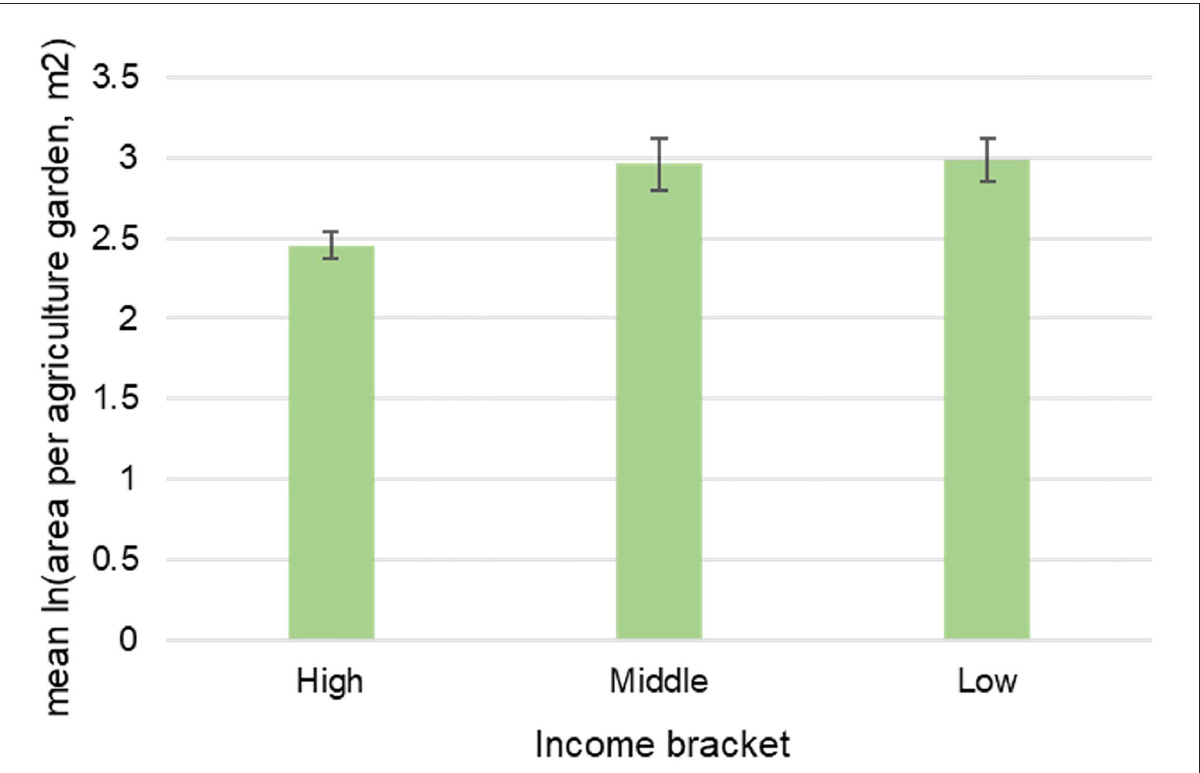
FIGURE3 Natural log-transformed mean area per agriculture garden by income bracket (low, middle, high) in the Twin Cities. Error bars represent the 95% confidence interval of the displayed mean.